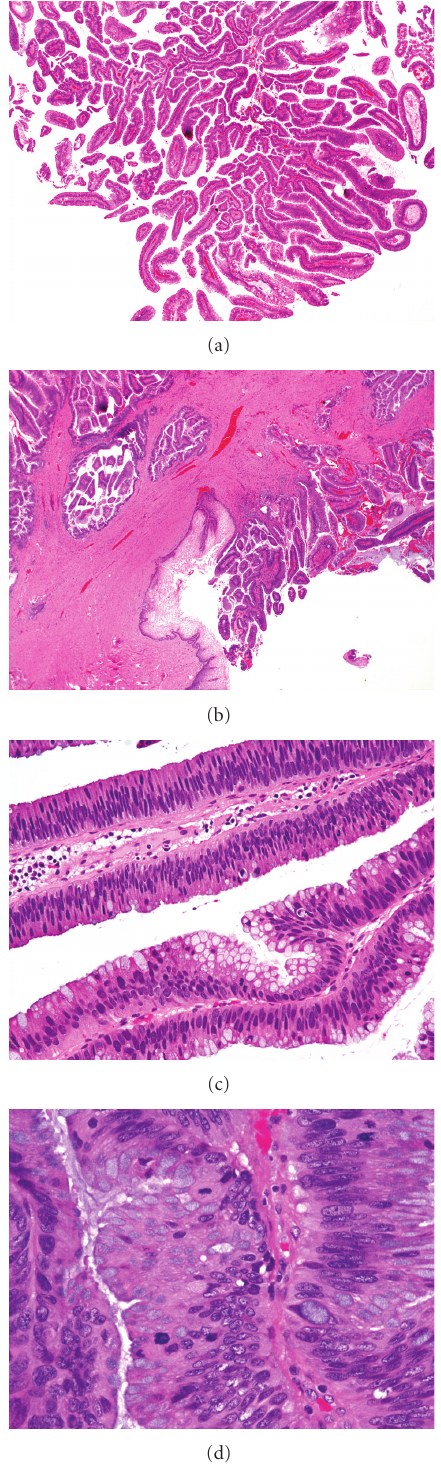
Figure 1: (a) Papillary fronds with delicate fibrovascular core (H&E, X20); (b) border of villous adenoma with squamous epithelium in the urethral diverticulum (H&E, X40); (c) columnar epithelium with abundant goblet cells demonstrating nuclear stratification, surface mitotic figures and loss of polarity (H&E, X100); (d) abundant mitosis, including atypical forms (H&E,